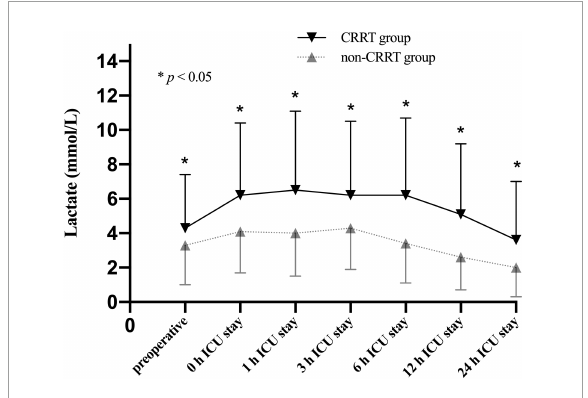
FIGURE3 Lactate clearance (mean and standard deviation) of patients in the CRRT group and the non-CRRT group at multiple time